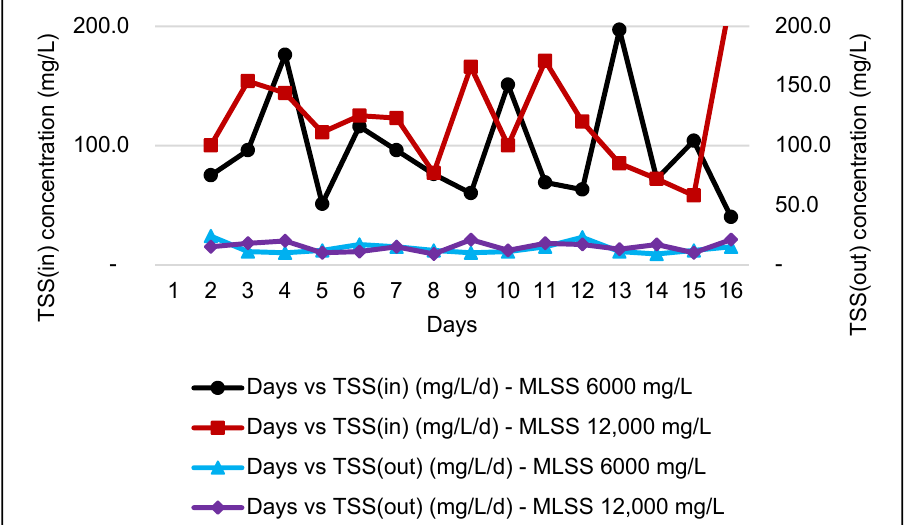
Figure 6. Graph of TSS influent and effluent for an MBR system MLSS values of 6000 mg/L and 12,000 mg/L by using an FS membrane.